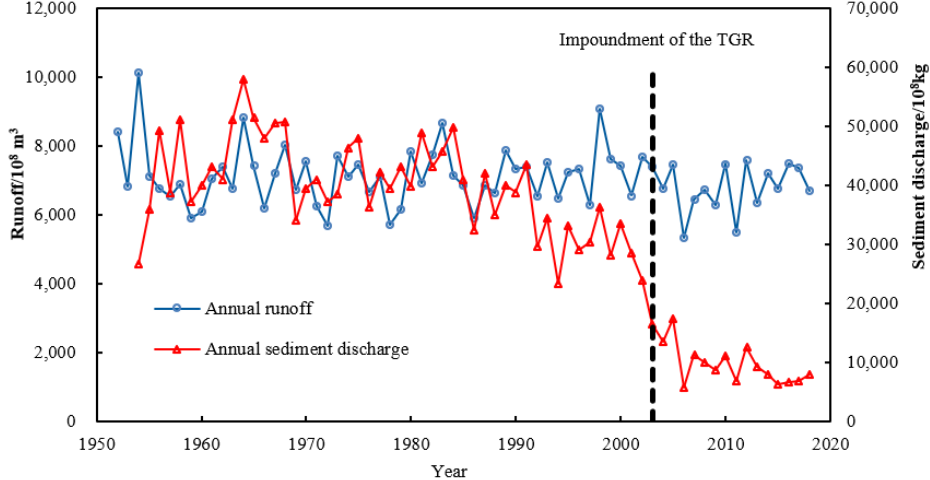
Figure 3. Temporal variations in the flow and sediment regimes at Hankou Hydrological Station.